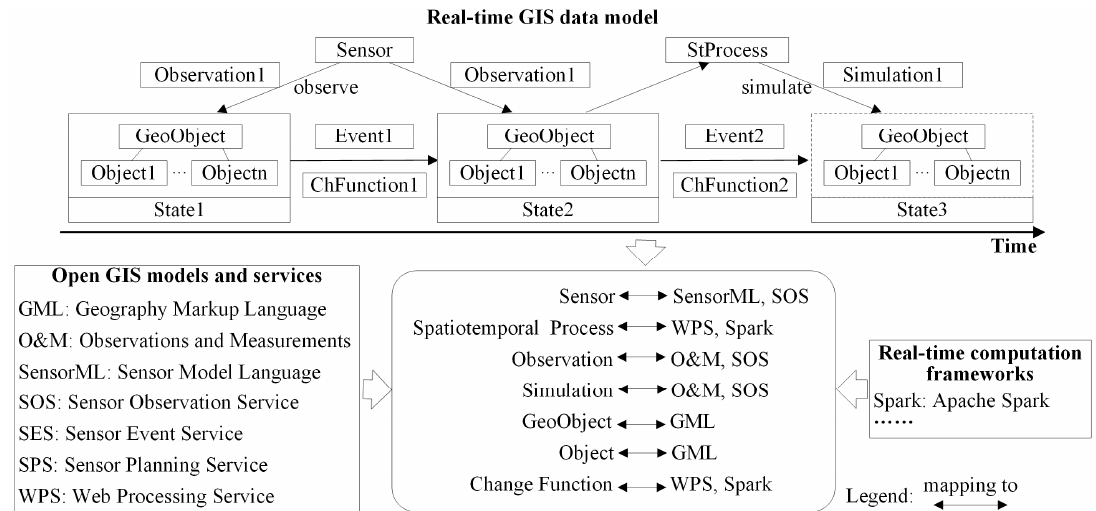
Figure 2. The mapping relationships among real-time GIS data models, open GIS models and services, and real-time computation frameworks.